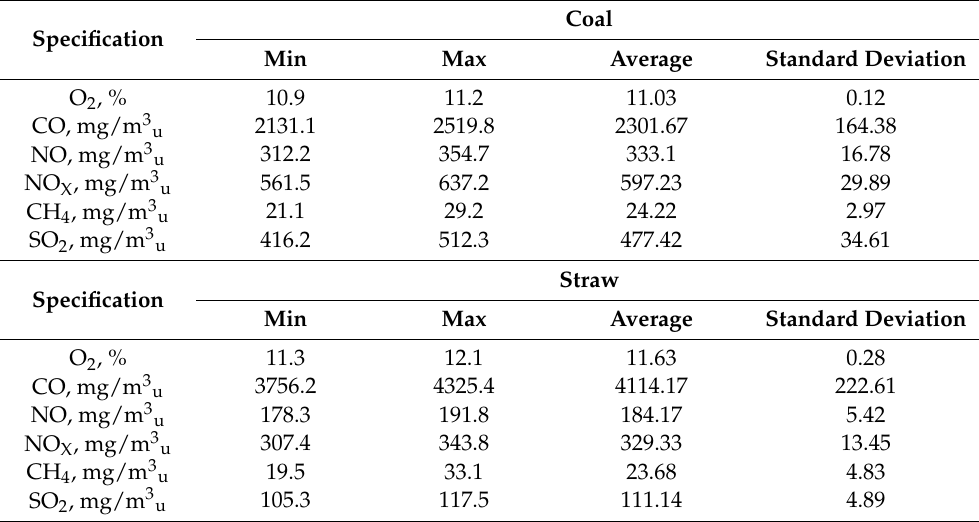
Table 4. Results of the measurement of pollutants from the combustion of hard coal and straw.